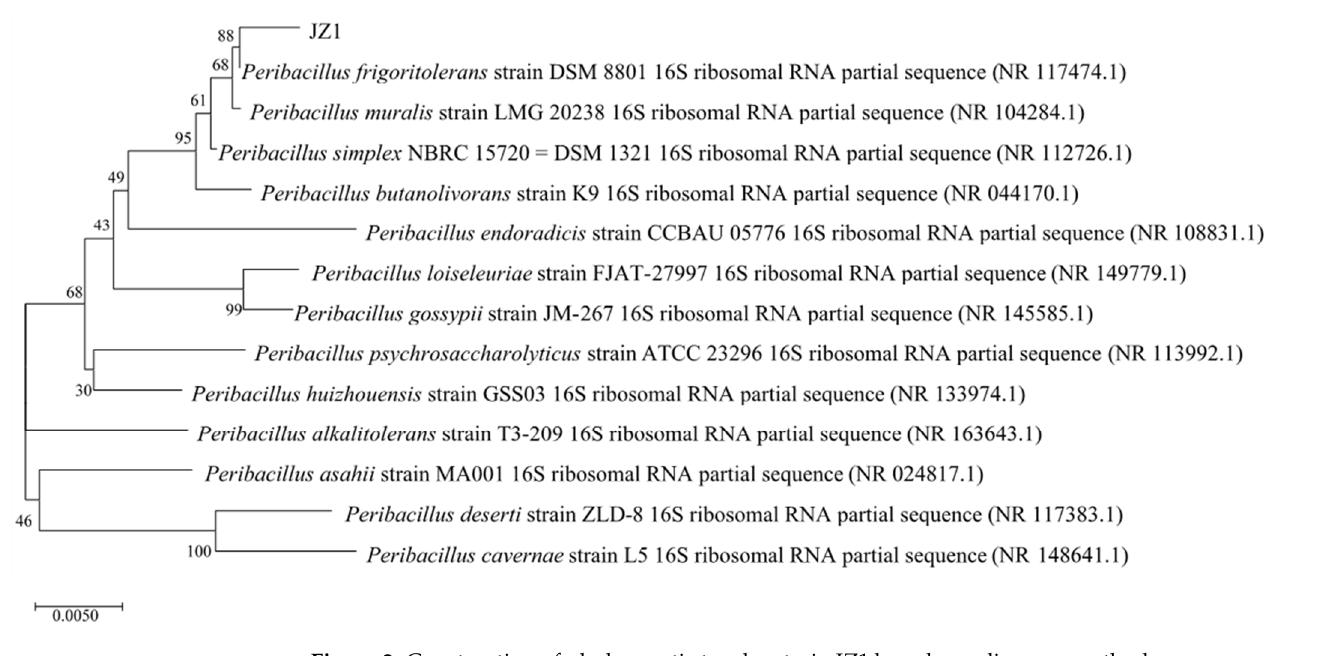
Figure 2. Construction of phylogenetic tree by strain JZ1 based on adjacency method. As shown in Figure 2, strain JZ1 and Peribacillus frigoritolerans DSM8801 belong to the same branch, which indicates that they have the closest genetic relationship